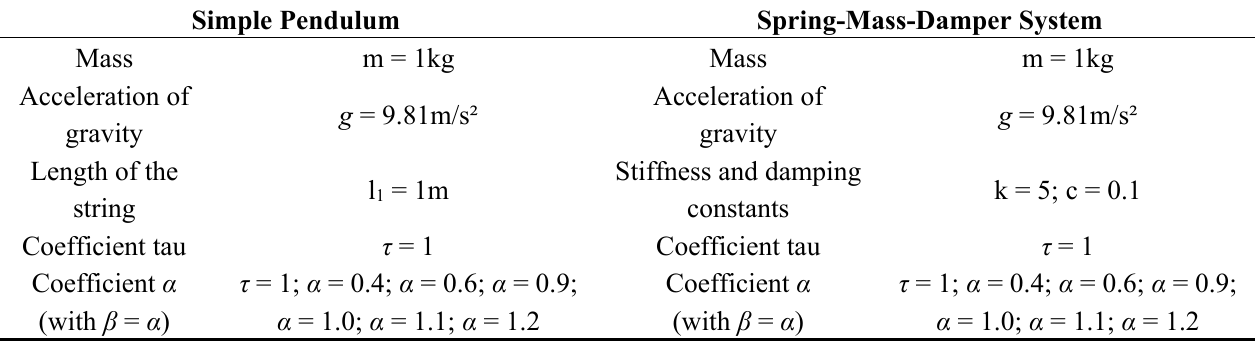
Table 2. Simulations parameters for all the three